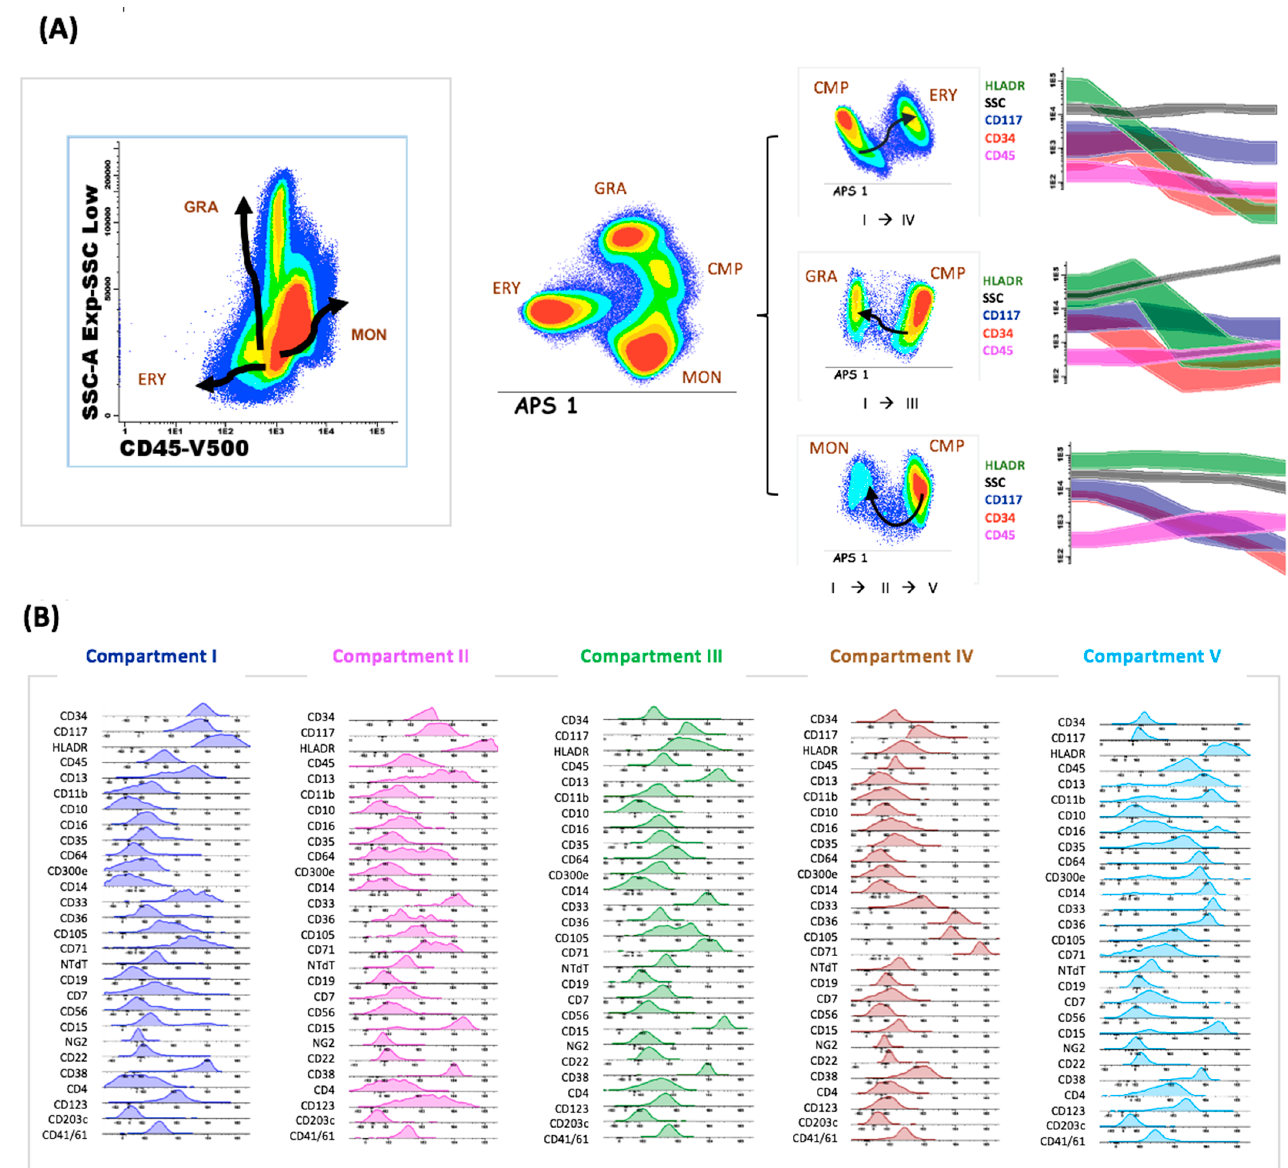
Figure 2. ( A ) Identification of 5 different maturational compartments attending to the expression of the backbone markers (CD45/CD34/CD117/HLADR) and SSC in an APS graph. Changes in the intensity of the backbone markers throughout consecutive maturational compartments. The common myeloid progenitor (CMP) is represented by compartment I. The monocytic differentiation (MON) occurs from compartment I to compartment II and finally compartment V. The granulocytic differentiation (GRA) arises from compartment I towards compartment III. Erythroid differentiation (ERY) derives from the common myeloid progenitor to compartment IV. ( B ) Complete immunophenotype of the identified compartments (I to V) using the Euroflow standardized AML/SMD panel.